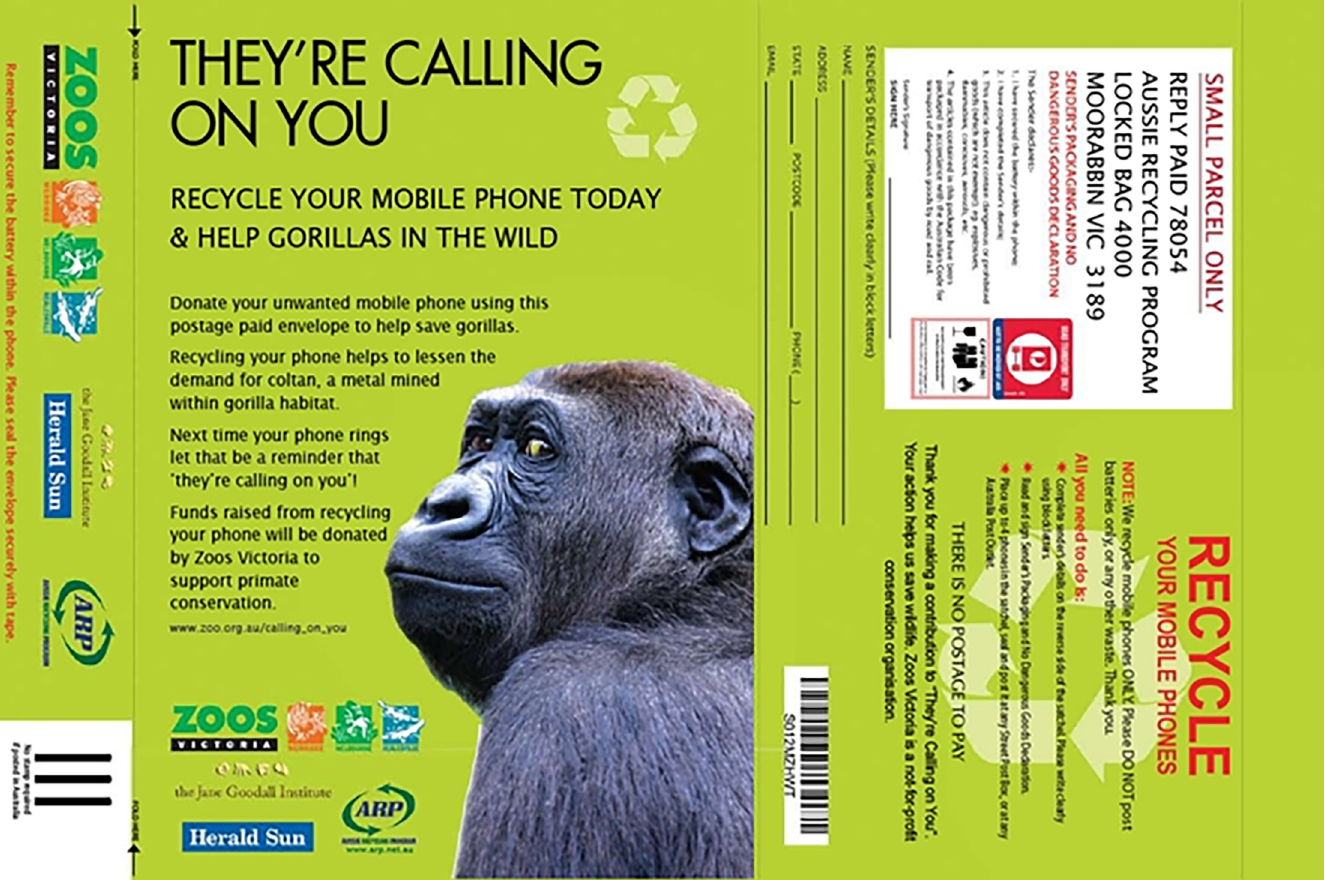
Fig 2. Artwork for TCOY satchel for return of mobile phones with image of Yakini on the front (left) and tracking barcode (for Herald Sun newspaper insert) and other information on the back (right).